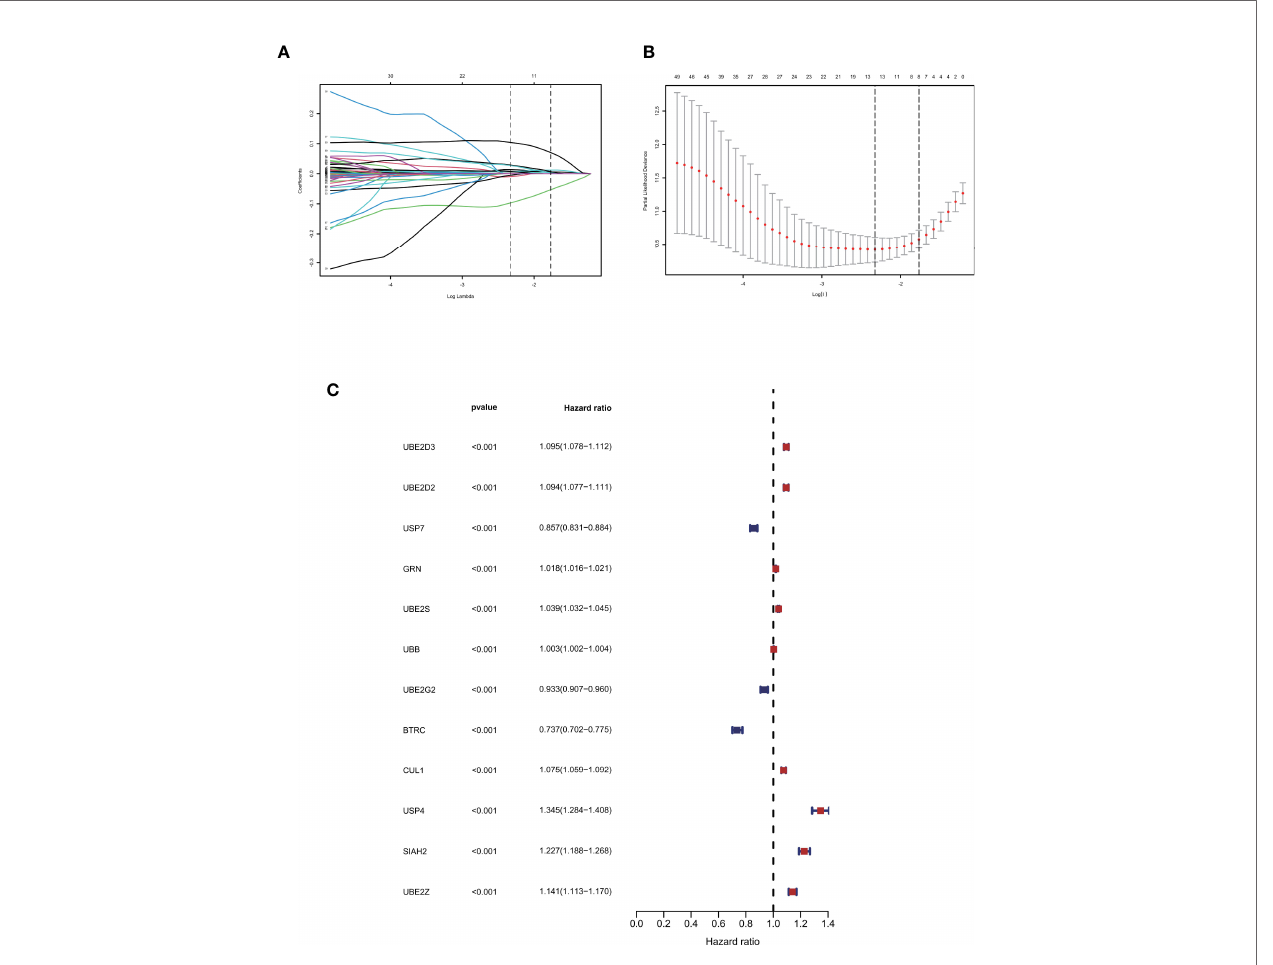
FIGURE 2 | Identi fi cation of prognostic ubiquitination-related genes. (A, B) Lasso regression to construct the prognostic model. (C) COX regression of the 12 model